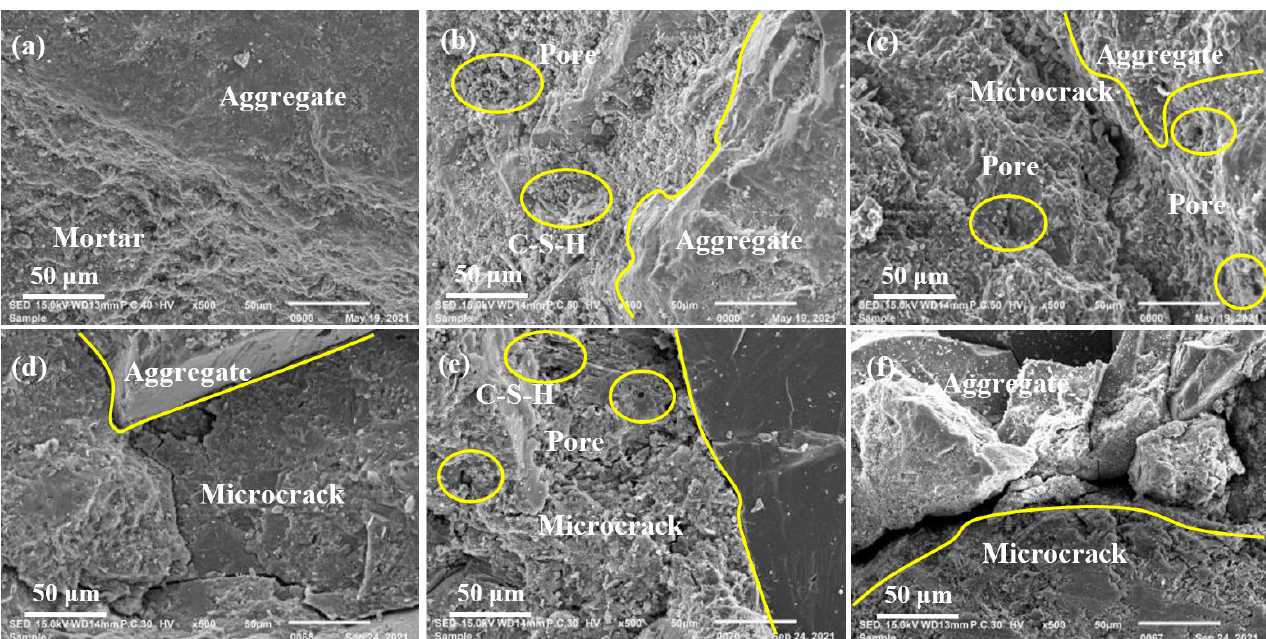
Figure 13. Micro morphology ( a ) NAC-0 ( b ) NAC-300 ( c ) NAC-600 ( d ) RAC1 ( e ) RAC3 ( f ) RAC5.